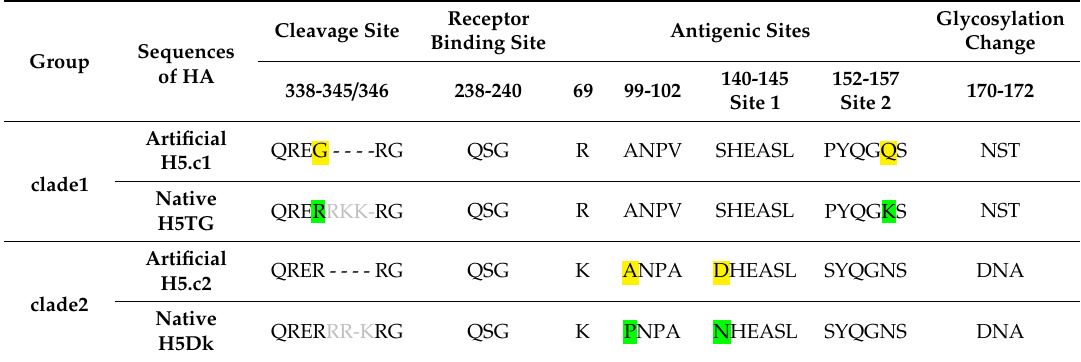
Table 1. The amino acid sequence at sites of protease cleavage, receptor binding, epitopes of antigenic sites, and variable glycosylation of haemagglutinin (HA) proteins.